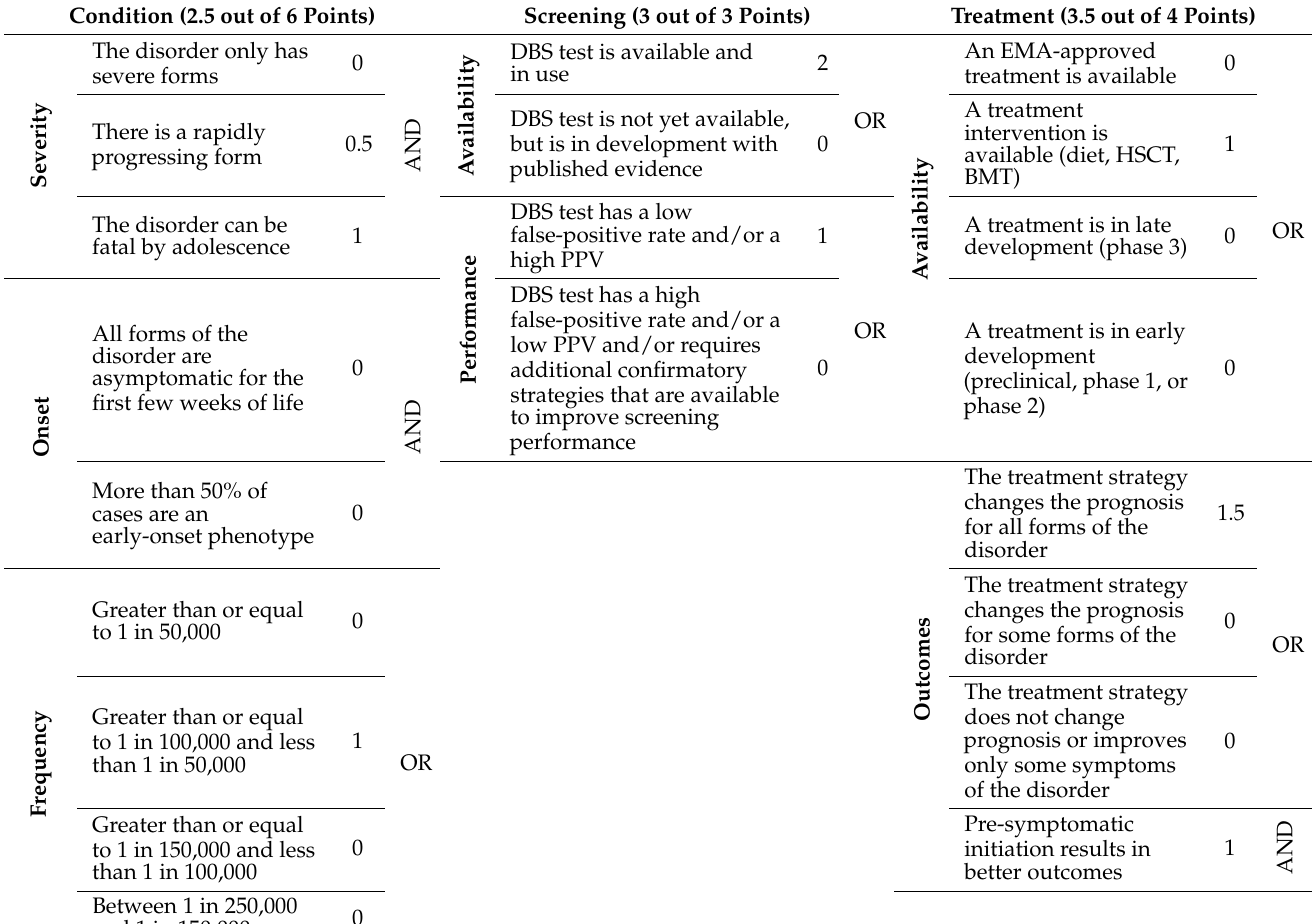
Table A9. Maple syrup urine disease (MSUD), 9